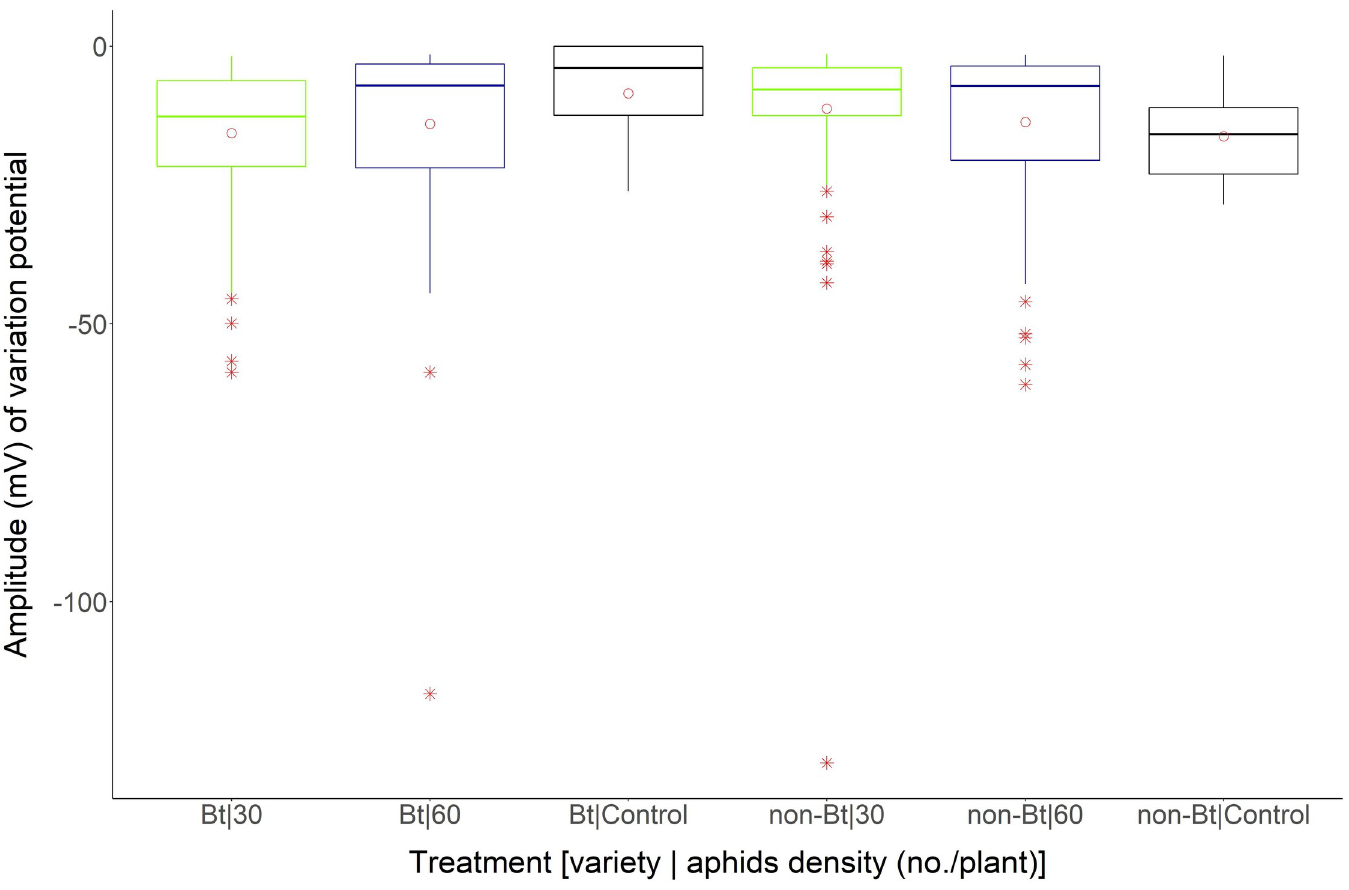
Fig 3. Boxplot of amplitude (mV) of variation potentials in Bt and non-Bt cotton plants exposed to different densities of A . gossypii Bt and non-Bt cotton plants exposed to densities of 30 and 60 aphids/plant and in the absence of aphids (Control). Circle within the boxplot corresponds to mean of time for each treatment. Asterisk out of the boxplot corresponds to outlier for each treatment.